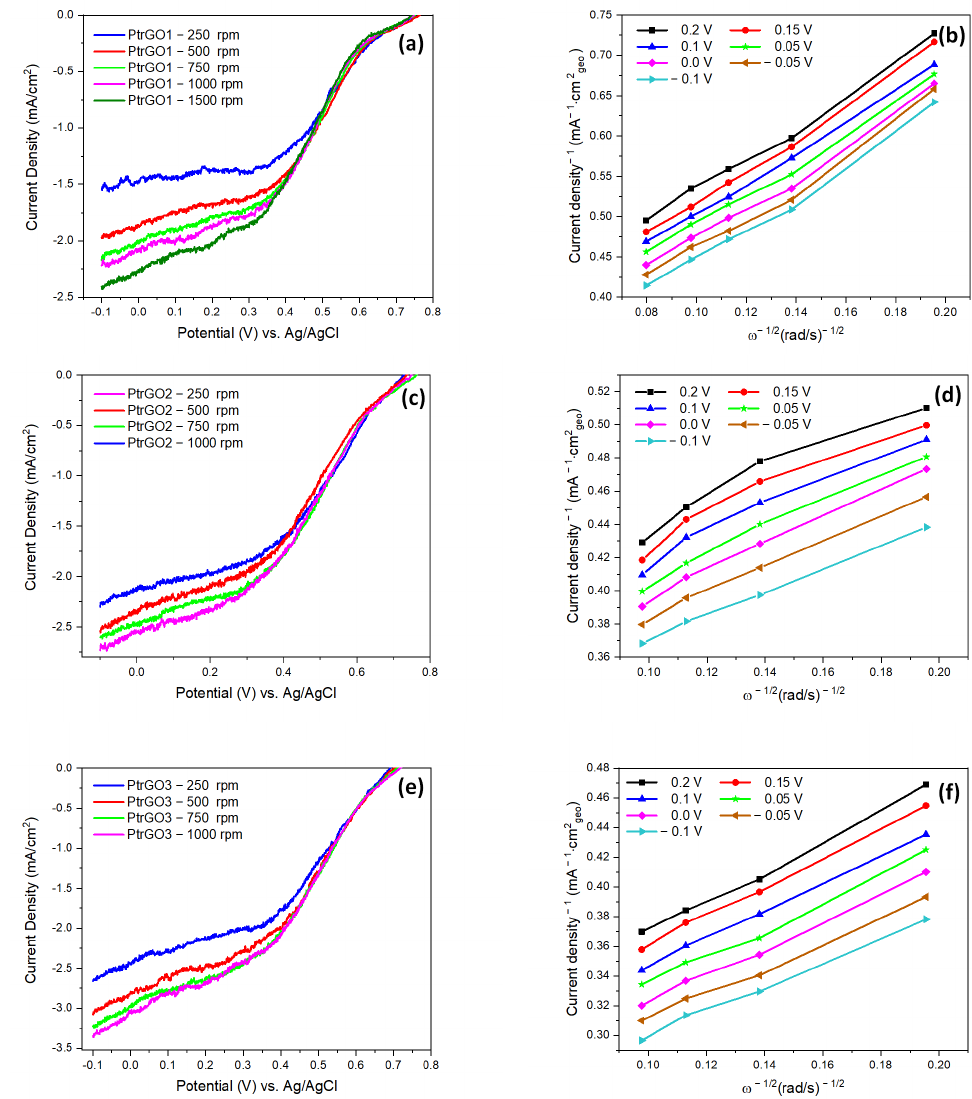
Figure 10. LSV plots for PtrGO1, PtrGO2 and PtrGO3 recorded at 5mV/s ( a , c , and e ) and the calcu- lated Koutecky–Levich plots ( b , d , and f